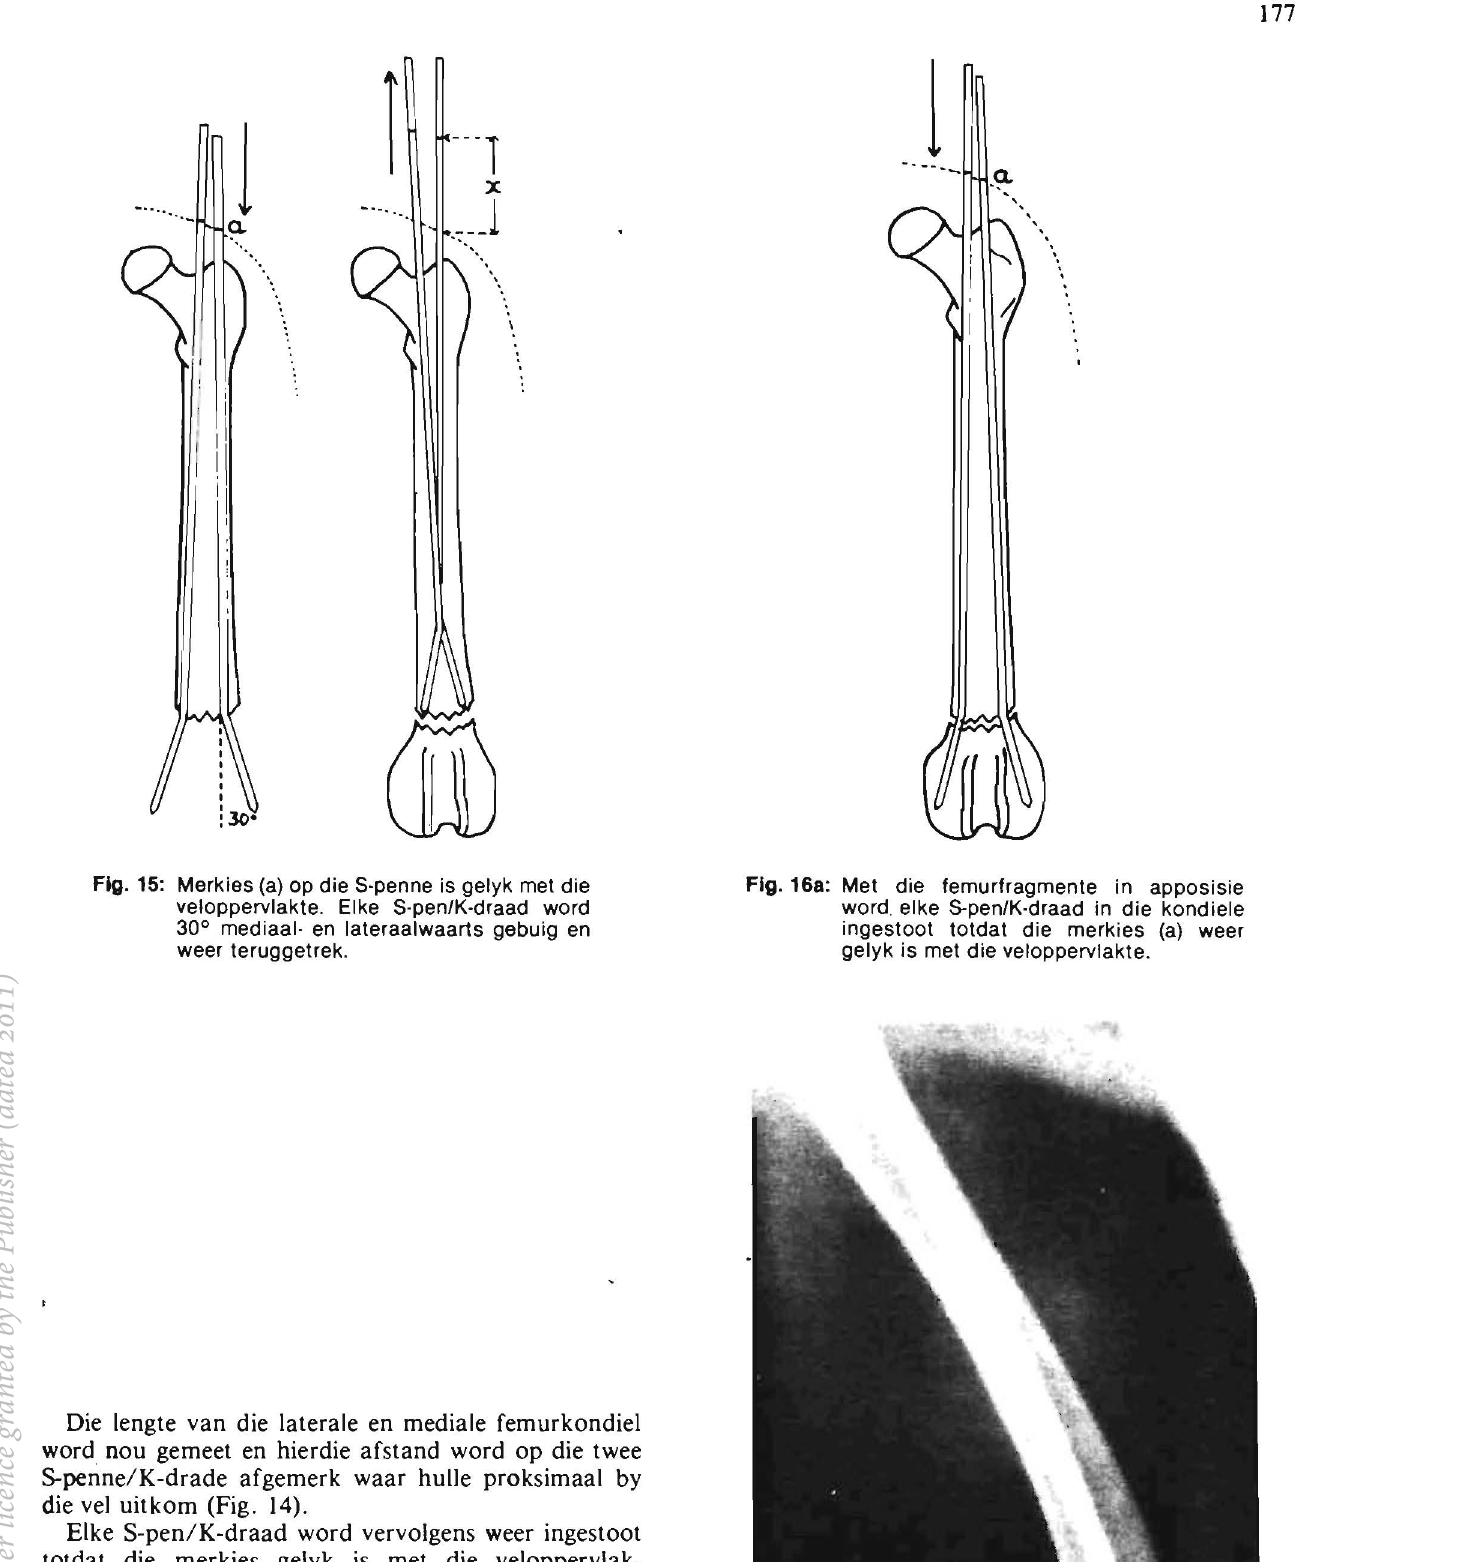
Fig. 16b: Onder·redusering van die distale femur· fragment - die dun Steinmannpenne het baie min sponsbeen om in te